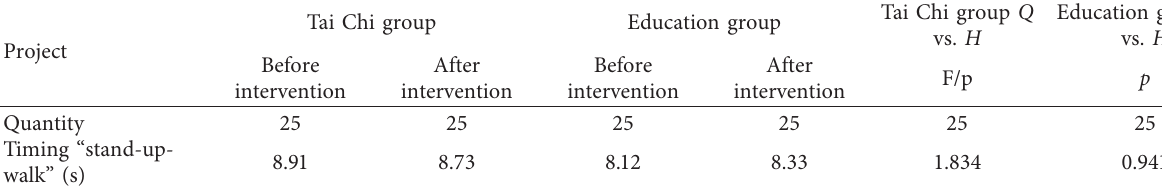
Table 2: Time change of “stand-up-walk” before and after intervention.